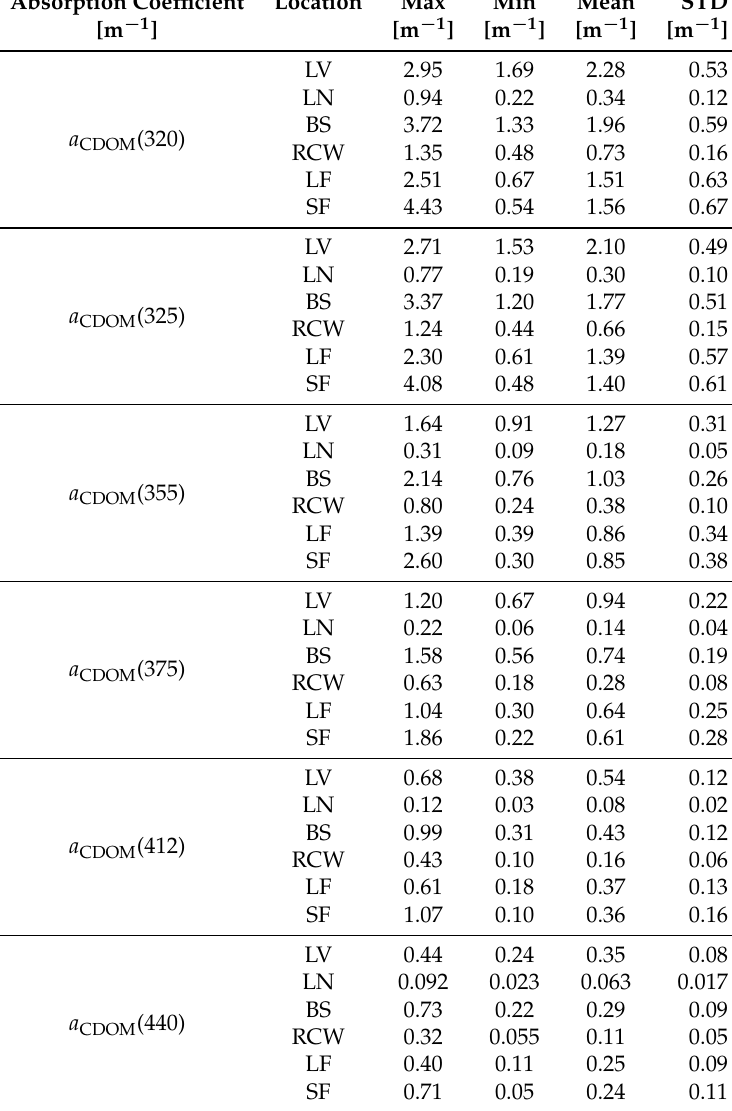
Table 2. The maximum (max), minimum (min), mean, and standard deviation (STD) values for the measured colored dissolved organic matter (CDOM) absorption coefficients at 320 nm [ a CDOM ( 320 ) ], 325 nm [ a CDOM ( 325 ) ], 355 nm [ a CDOM ( 355 ) ], 375 nm [ a CDOM ( 375 ) ], 412 nm [ a CDOM ( 412 ) ], and 440